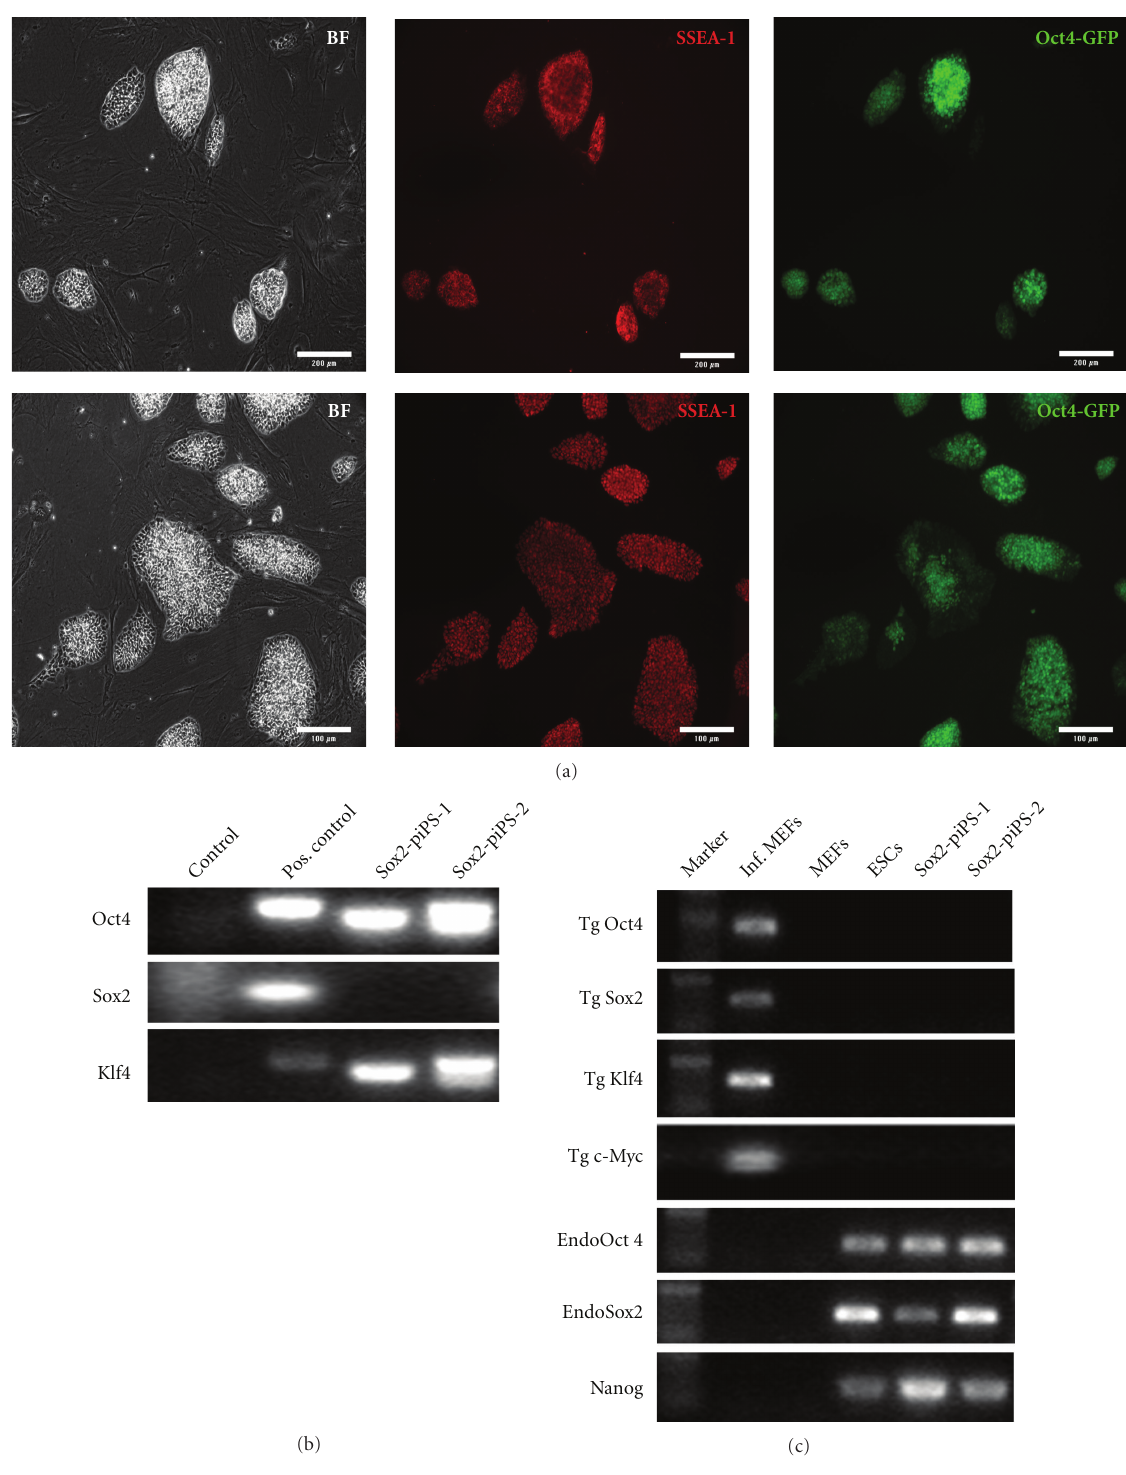
Figure 4: Cellular and molecular characterization of iPS clones derived by Sox2 protein transduction into OKC-MEFs. (a) Pictures of isolated cell lines Sox2-piPS-1 (upper row) and Sox2-piPS-2 (lower row) exhibiting brightfield (BF), staining against pluripotency-associated marker SSEA-1 and native GFP fluorescence. Sox2-piPS-1 cell line was clonally isolated from 400 nM Sox2-TAT treatment from day 1 to 5, and Sox2-piPS-2 was derived from 200 nM condition (day 5 to 10) Scale bar = 100 μ m. (b) PCR analysis of genomic DNA demonstrating genomic integration of Oct4 and Klf4 transgenes. As expected, no transgenic Sox2 was detected in Sox2-piPS clones excluding possibility of contamination. (c) RT-PCR analysis demonstrating transgene silencing in Sox2-piPS cells. Primers specific for transgenic Oct4, Sox2, Klf4, and c-Myc were used. Additionally, we analyzed endogenous Oct4, Sox2, and Nanog transcripts. RNA preparations from infected (Inf.) and uninfected MEFs as well as ES cells served as